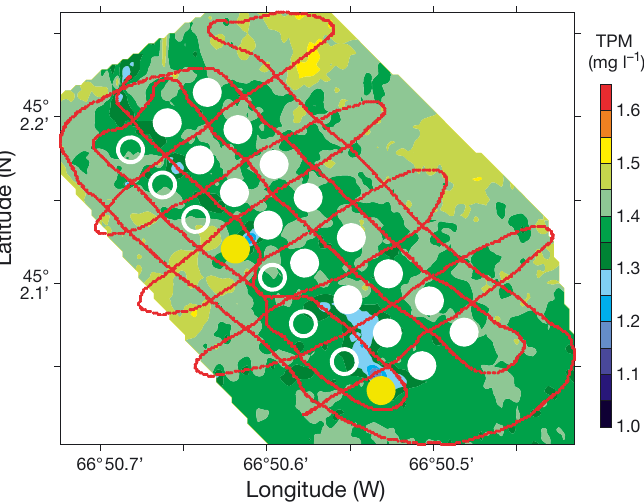
Fig. 5. Colour-scaled contour plots of total suspended partic- ulate matter (TPM; mg l −1 ) within the 1−5 m depth interval at the Man-O-War salmon farm on 10 September 2009 from 13:00 (low slack tide) to 14:50 h (early flood) GMT. Sampling locations along the Acrobat tow track are shown as lines of red dots (n = 14003). White circles indicate the locations of full and empty salmon net-pens (solid white circle for pens containing fish) and yellow circles locate the 2 pens used for mussel culture. The observed surface water flow ranged from north to